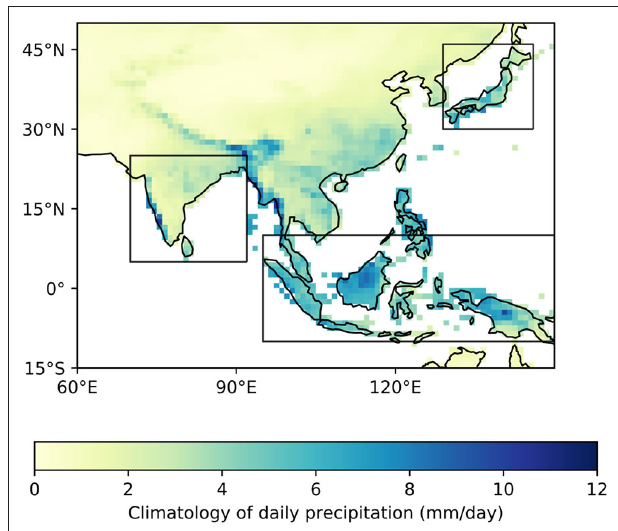
FIGURE 1 | Climatology of the annual daily precipitation (mm/day) extracted from APHRODITE. Black boxes show the regions used in this document: Japan (129 ◦ E-146 ◦ E, 30 ◦ N-46 ◦ N), India (70 ◦ E-92 ◦ E, 5 ◦ N-25 ◦ N), and the Maritime Continent (95 ◦ E-150 ◦ E, 10 ◦ S-10 ◦